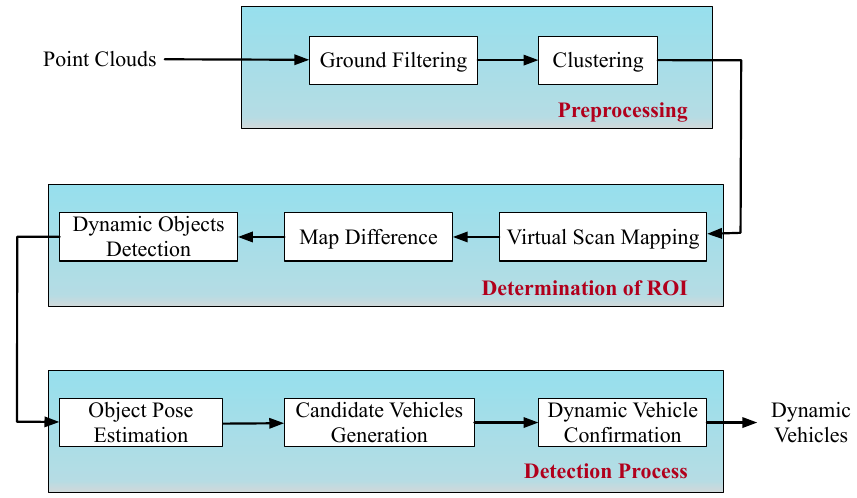
Figure 5. Framework of the dynamic vehicle detection based on pose estimation with convex-hull model